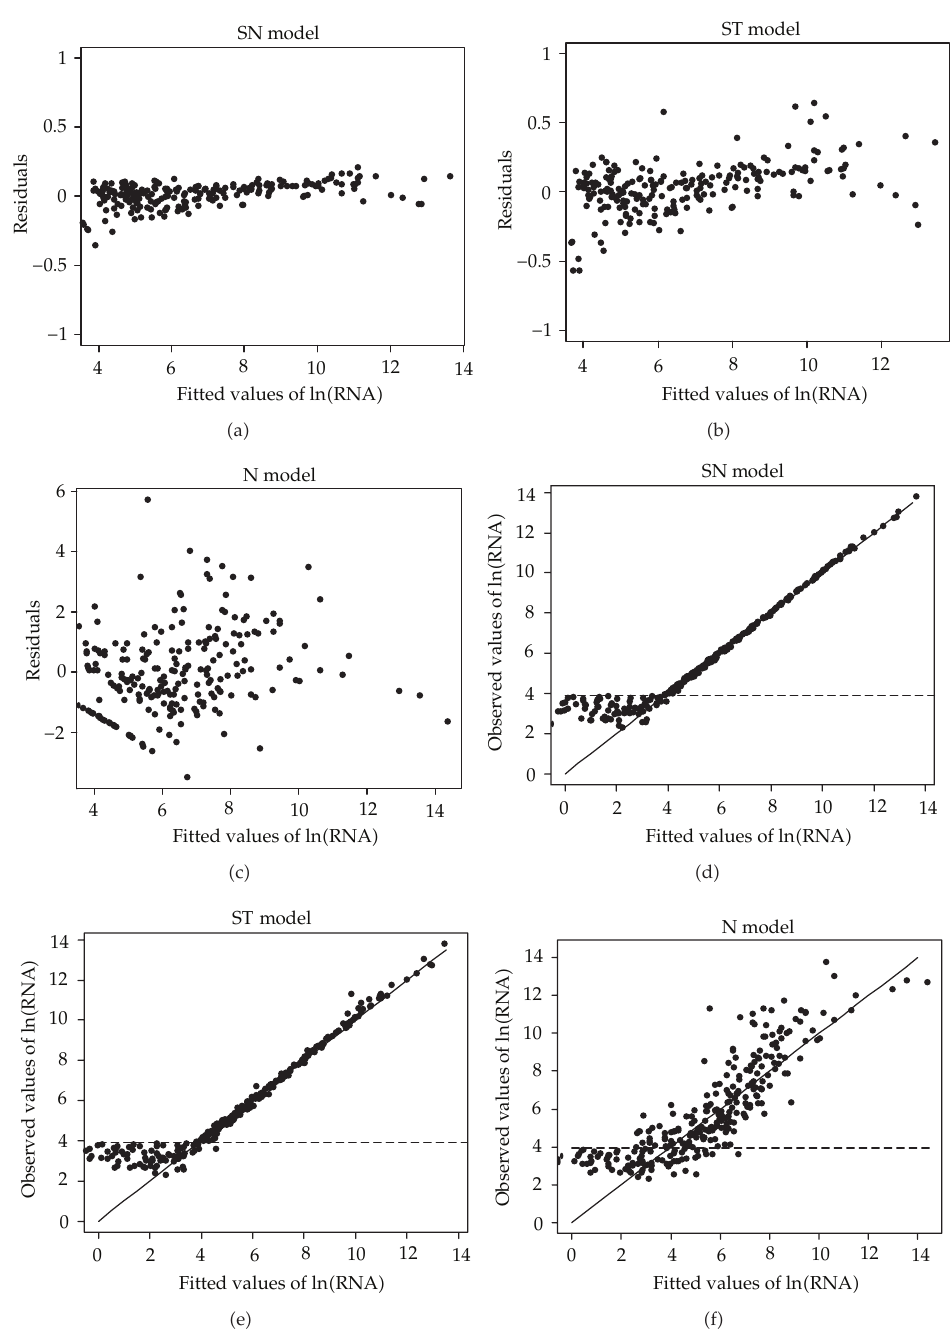
Figure 2: The goodness-of-fit. (cid:3) a–c (cid:4) : Residuals versus fitted values of ln (cid:3) RNA (cid:4) under skew-normal (cid:3) SN (cid:4) , skew-t (cid:3) ST (cid:4) , and normal (cid:3) N (cid:4) models based on the JM method; the values below detection limit (cid:3) ln (cid:3) 50 (cid:4)(cid:4) are not included in the plots since there are no corresponding residuals but only predicted values. (cid:3) d–f (cid:4) : Observed values versus fitted values of ln (cid:3) RNA (cid:4) under SN, ST, and N models, where the horizontal line at ln (cid:3) 50 (cid:4) represents the detection